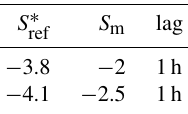
Table 1. Detection parameters applied for CHAMP and Swarm